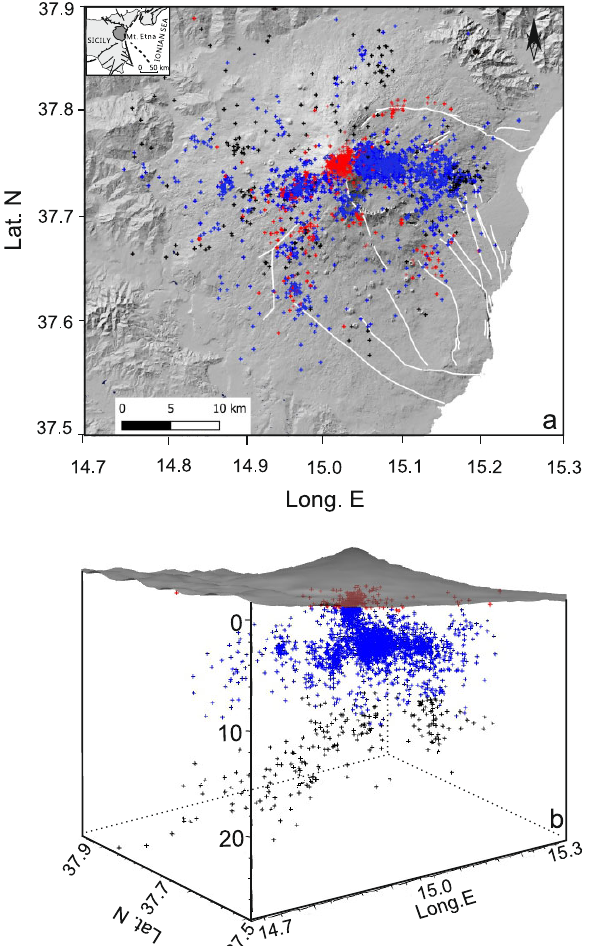
Fig. 1 Mt. Etna Seismicity and tectonic lineaments. ( a ) Map of Mt Etna volcano and main faults and tectonic lineaments (white lines). Seismicity in the period January 2019 – February 2021 is shown, with crosses color- coded for hypocentral depth (red = z ≤ 3 km, blue = 3 < z ≤ 12 km, black = z ≥ 12 km, b.s.l.). ( b ) 3D view of the seismicity distribution, note the central shallow and the peripheral deep